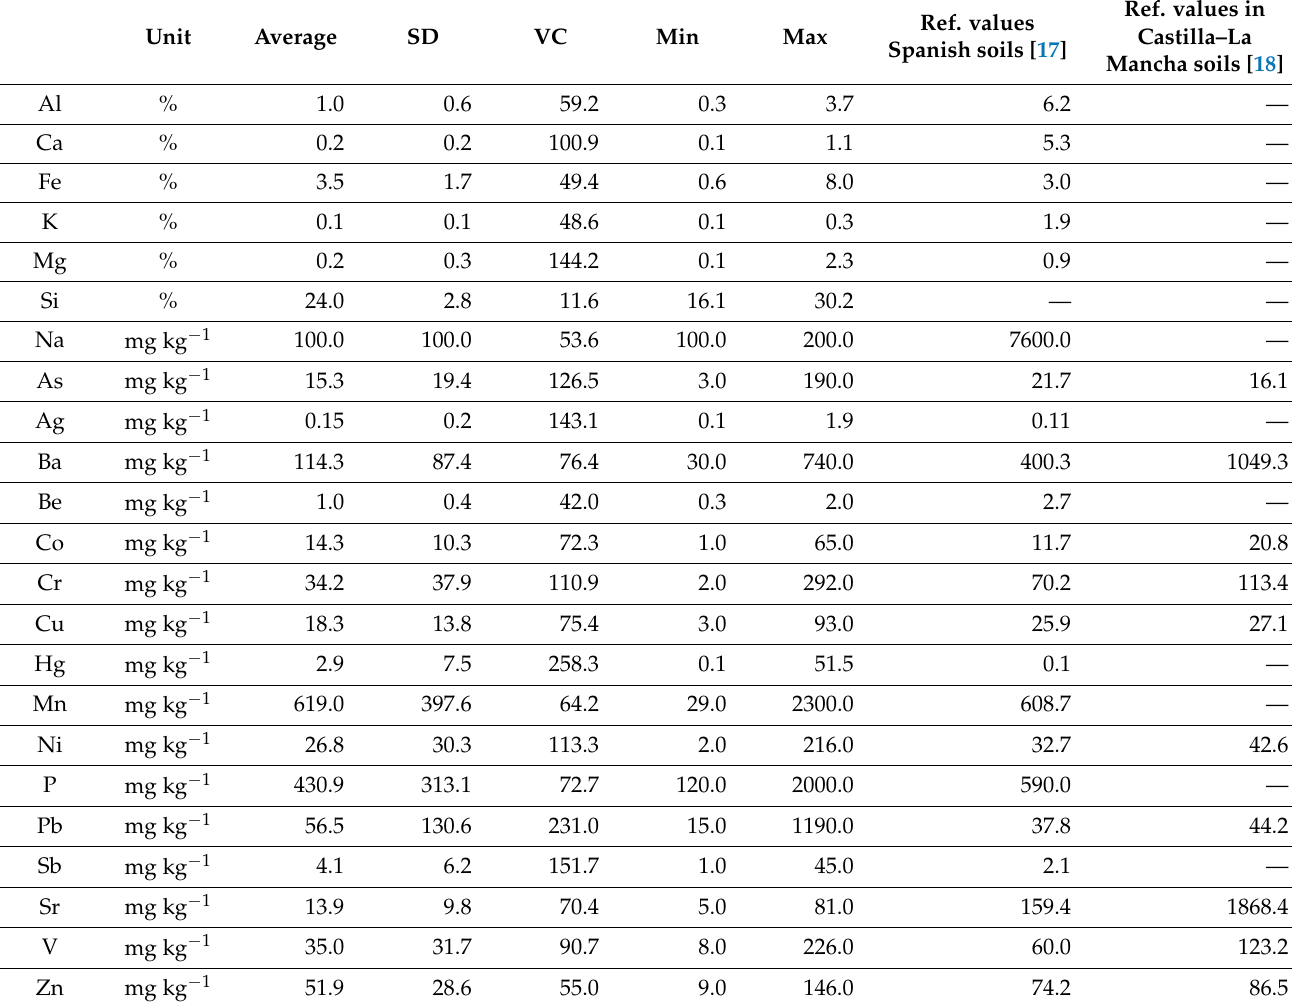
Table 2. Statistical summary of major (in %) and trace elements (in mg kg − 1 ). Abbreviations: standard deviation (SD); variation coefficient (VC). Complete data available in Table